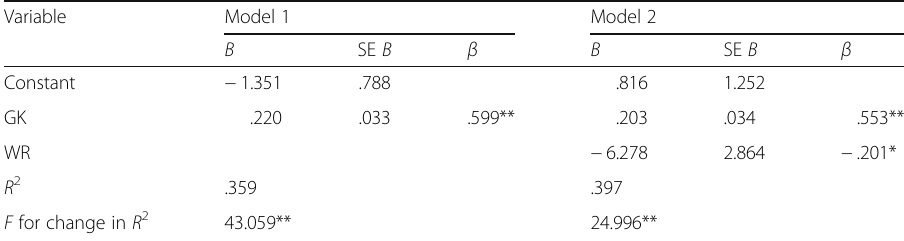
Table 10 Summary of the stepwise regression analysis for the OE test scores